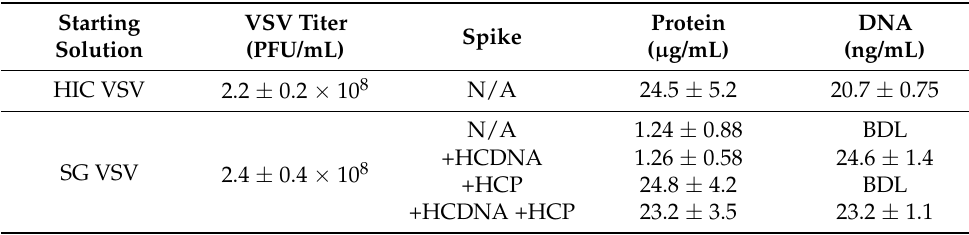
Table 1. Measurements of virus titer, protein, and DNA concentrations for the various vesicular stomatitis virus (VSV) solutions. Results are reported as the average ± the standard deviation, with BDL indicating a concentration below the assay detection limits and N/A indicating that no spiking was